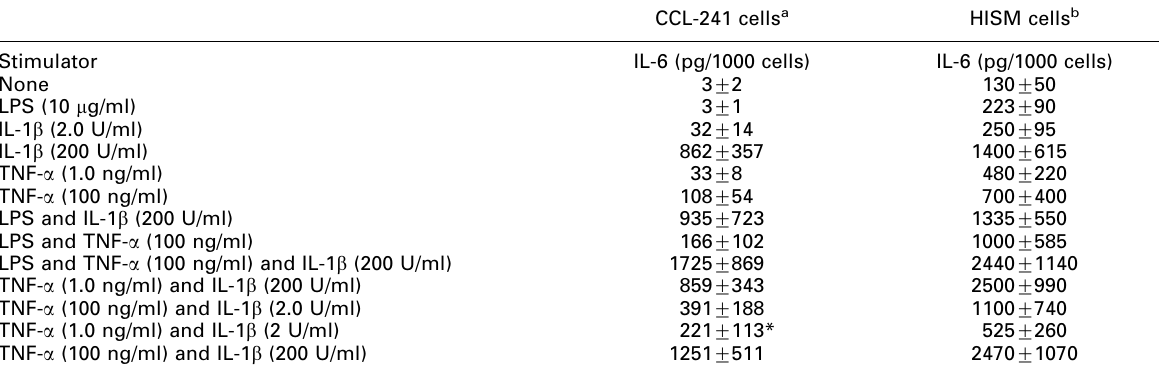
a n (cid:5) / 4 experiments/condition, *p B / 0.05 versus IL-1 b (2.0 U/ml) versus TNF- a (1.0 ng/ml) (with Bonferroni correction for multiple comparisons). b n (cid:5) / 6 experiments/condition, no values reached statistical significance of p B / 0.05 versus appropriate control (with Bonferroni correction for multiple